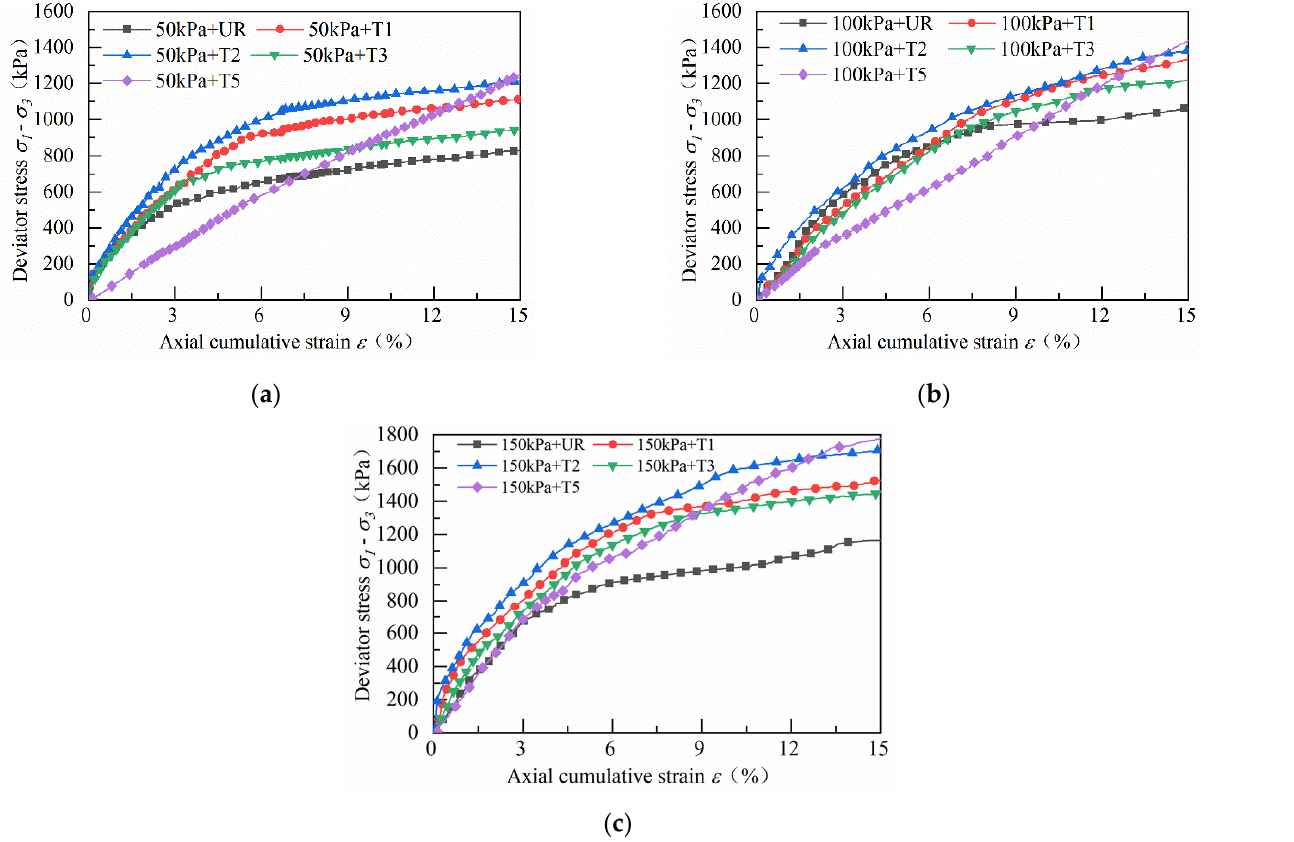
Figure 9. Stress–strain relationship curves for waste tyre reinforced track bed layers at three different confining pressures: ( a ) 50 kPa waste tyre reinforcement; ( b ) 100 kPa waste tyre reinforcement; ( c ) 150 kPa waste tyre reinforcement.